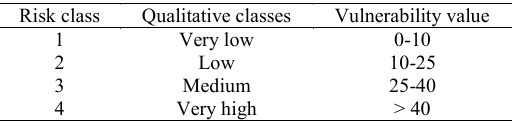
Table 6: Classes and qualitative categorization of risk value in the study area (Nazarinezhad, 2010) Risk class